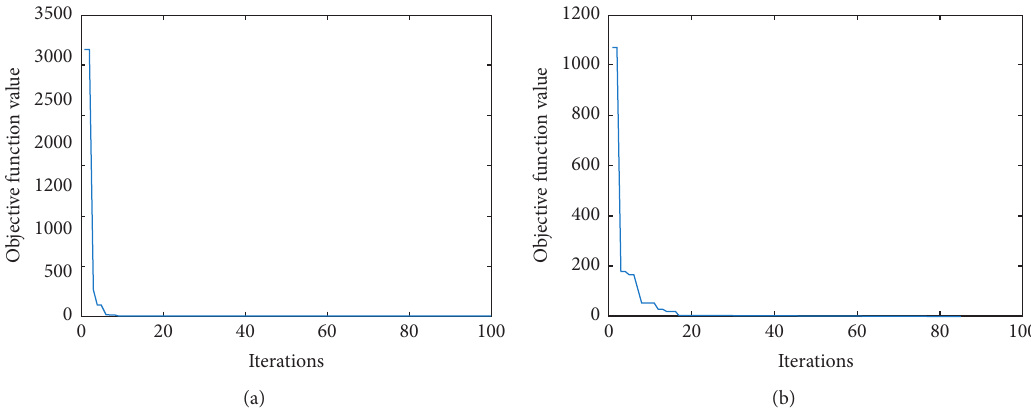
Figure 25: The relationship between the value of the objective function and the iterations. (a) 0.8PSO. (b) IPSO.